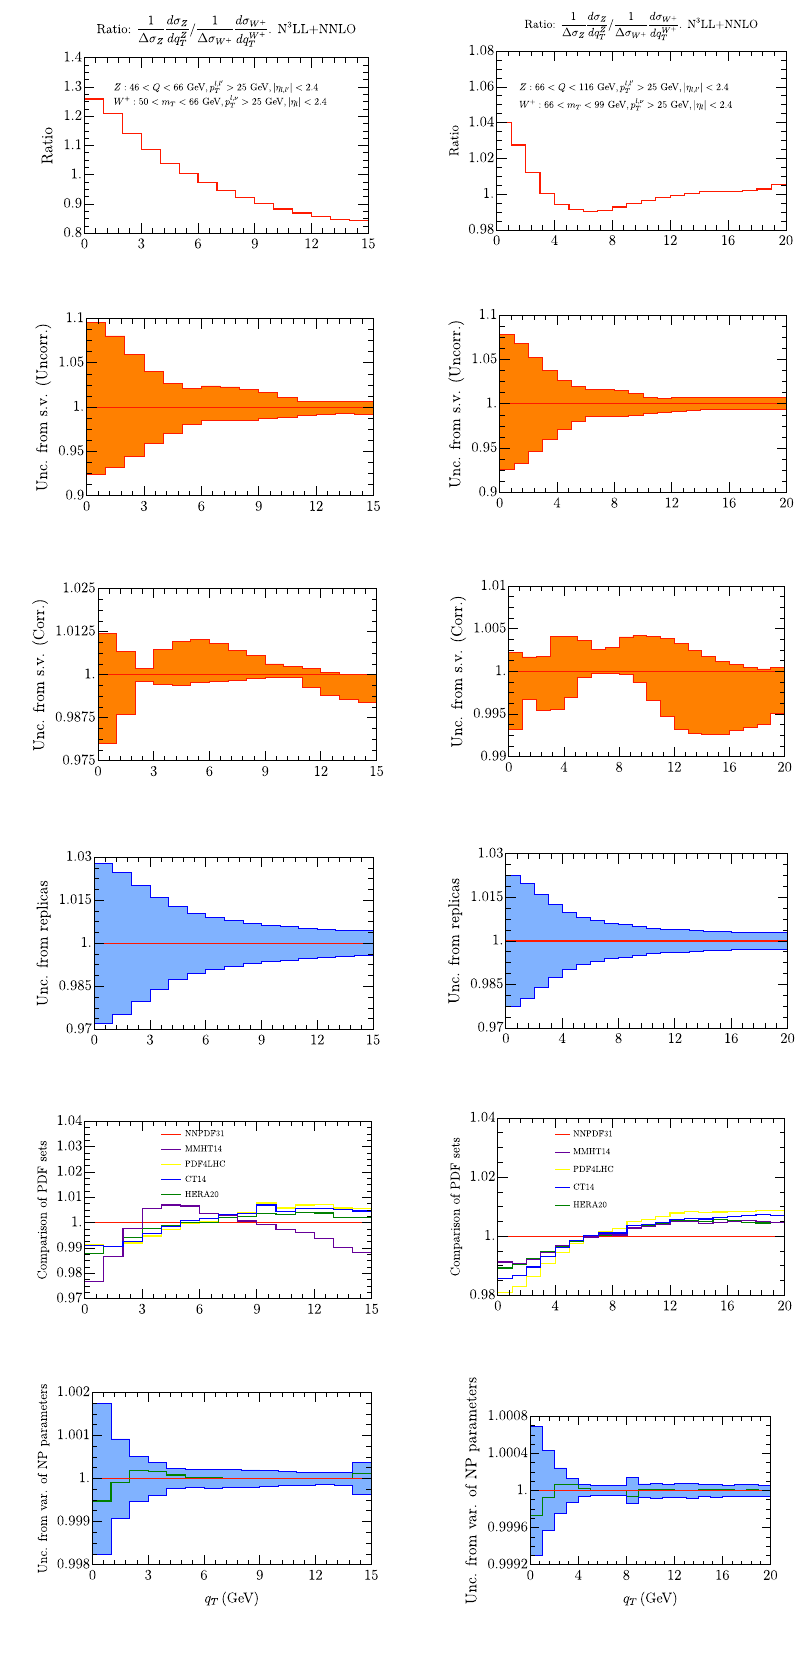
Fig. 5 Ratio of Z / W + spectrum for m T ∈ [ 50 , 66 ] GeV (left column) , and m T ∈ [ 66 , 99 ] GeV (right column). On the first row we have the Z / W − spectrum using the central replica of NNPDF31_nnlo_as_0118 [28]. Uncorrelated and correlated theoretical uncertainties are given in second and third row respectively. In the third line we have the error calculated as a variance in each bin of 100 replicas of the set NNPDF31_nnlo_as_0118 [28]. The uncertainty is referred to the average value of each bin (red line). The value of the observable given by the central replica is represented by the green line. On the fourth line we represent the value of each been with different sets of PDF. On the fifth row we have the uncertainty due to non-perturbative